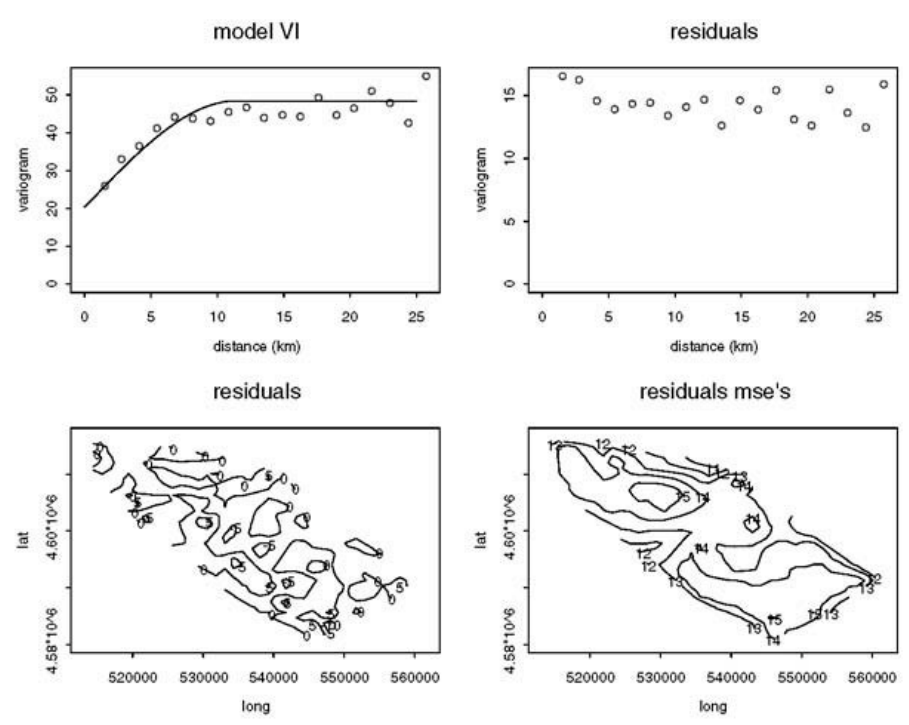
Figure 2 – Empirical and estimated spherical variogram for model VI, empirical variogram of residuals, contourplot (based on a linear interpolation) of residuals and their mse’s.